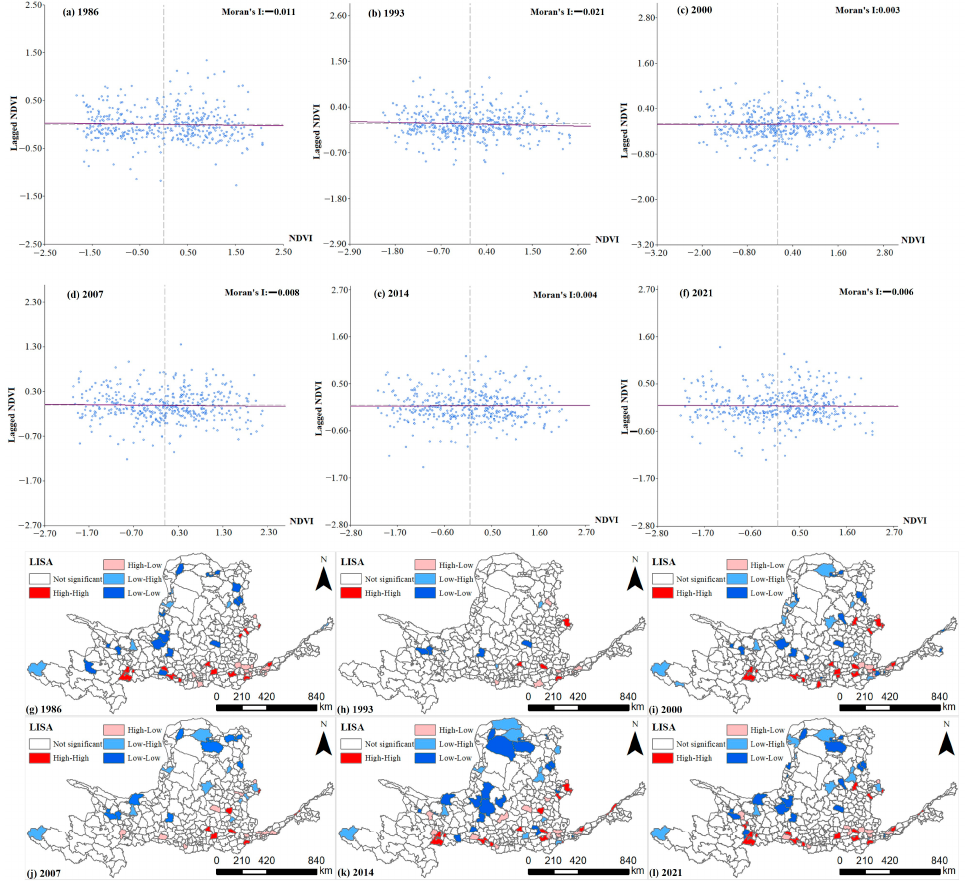
Figure 3. The Global Moran’s I scatter plot ( a – f ), the Local Moran’s I cluster maps ( g – l ) of NDVI from 1986 to 2021.